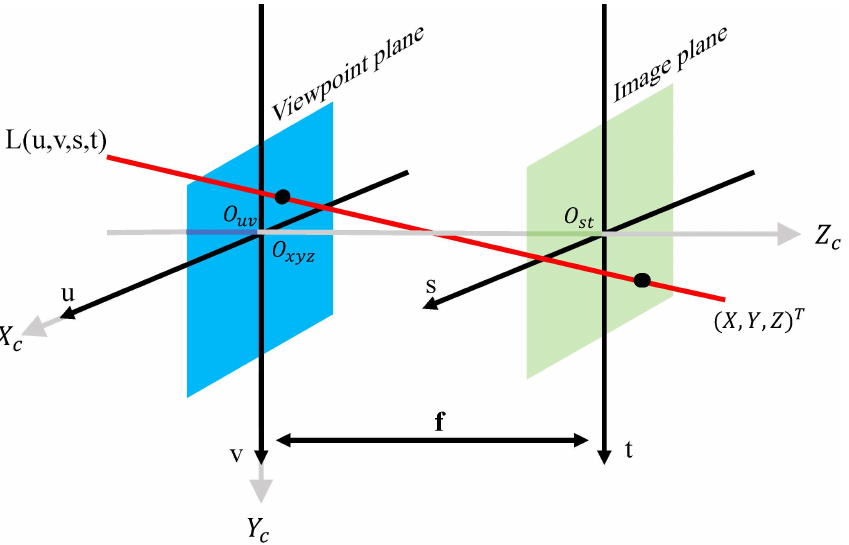
Figure 1. The two-plane parametric representation of the four-dimensional light